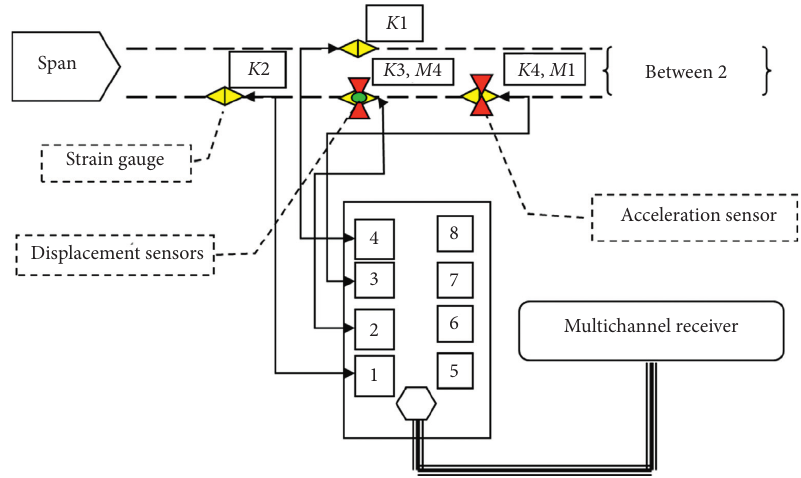
Figure 13: The process of receiving signals and processing deformation data. Table 1: Signals’ sample